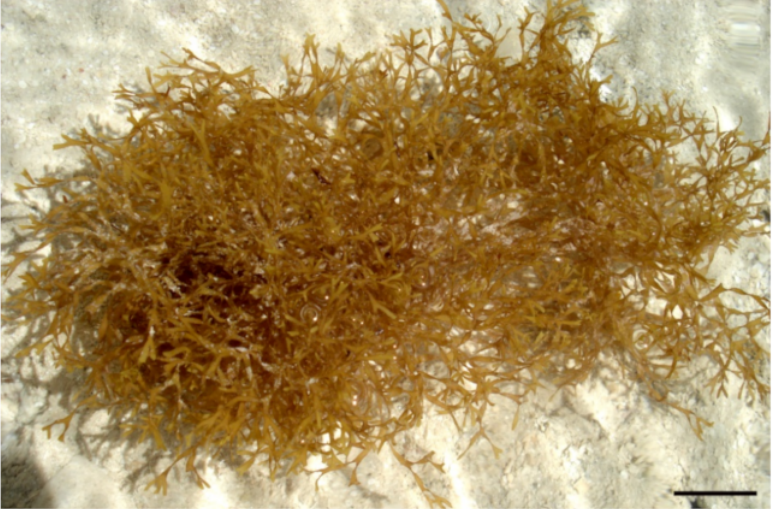
Figure 1. Dictyota dichotoma specimens from the Egyptian coastal water of Hurghada City, the Red Sea. Scale bar = 2